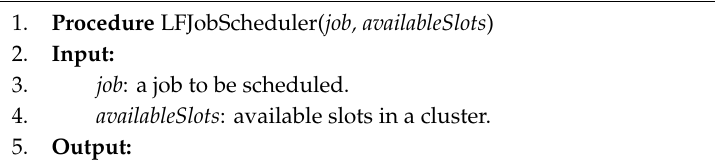
Algorithm 5 Locality / Fairness-aware job scheduler